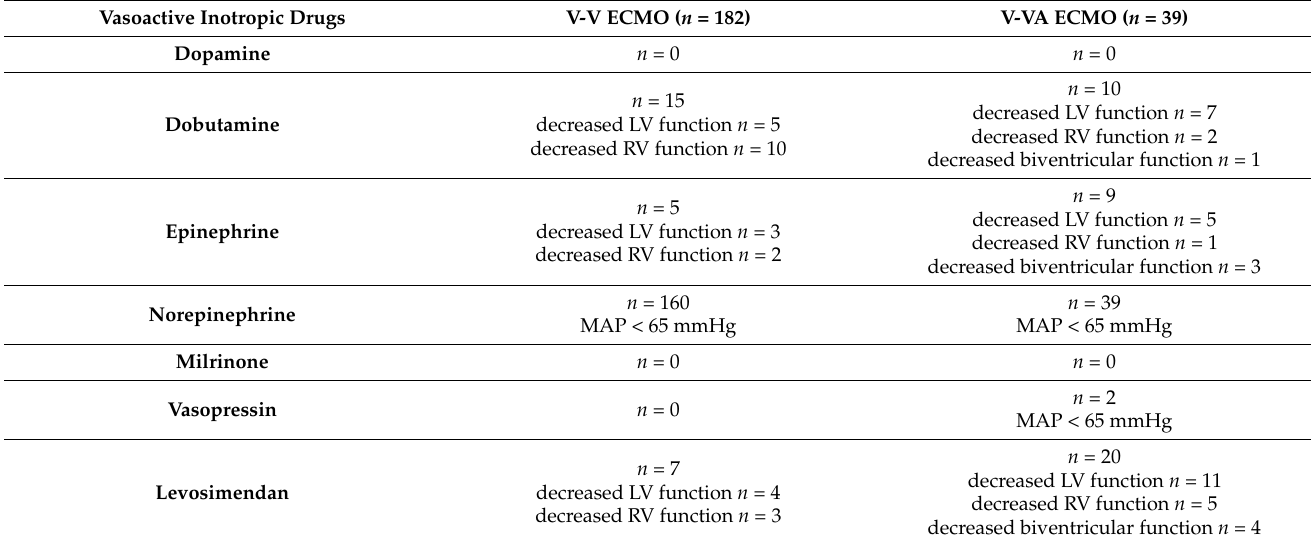
Table A2. Causality assessment of using vasoactive inotropic drugs prior to ECMO